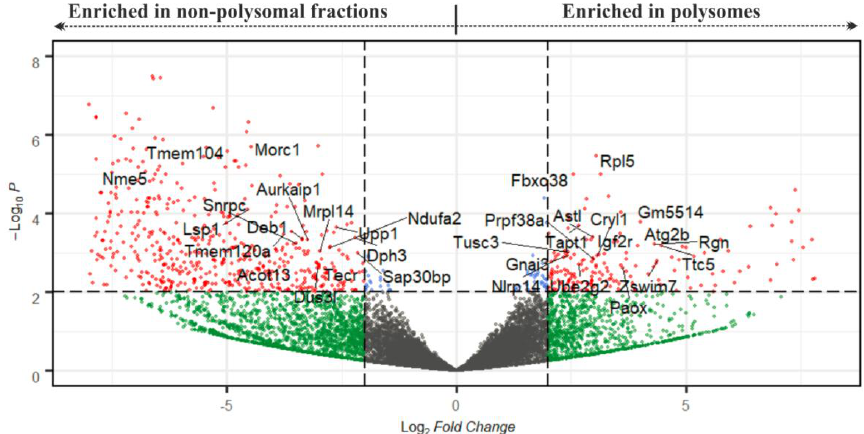
Figure 5. Volcano plot depicting transcripts according to their P / NP ratio after DeSeq2 analysis. The cut-off scores for the P/NP ratio (displayed as Log 2 Fold Change) and the adjusted p -value (P adj , displayed as –Log 10 P ) were set to 4 and 0.01, respectively. Red spots denote mRNAs that are significant in both parameters; cut-off scores are marked with dotted lines. Gene names highlight mRNAs with strong expression (with FPKM > 80 in at least one from P and NP datasets, Table